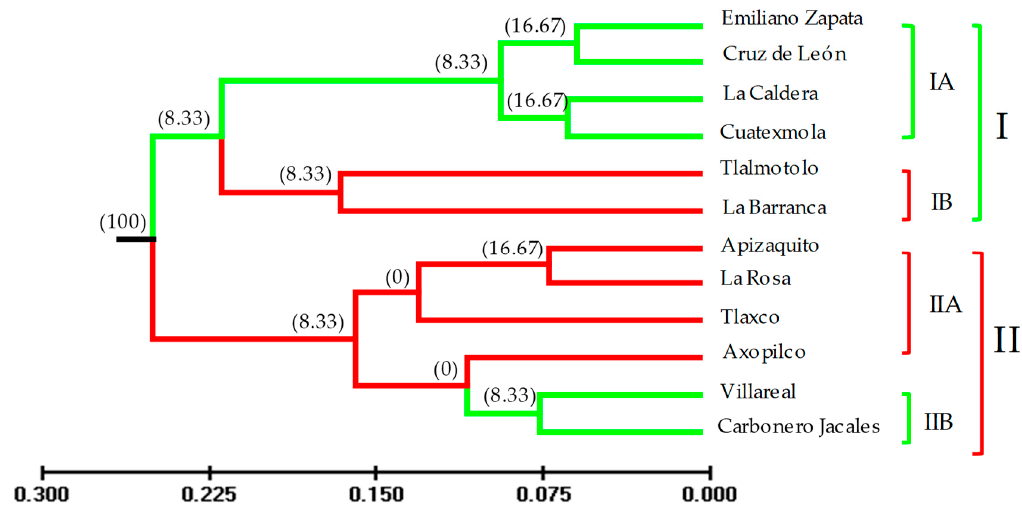
Figure 2. Graphical dispersion of 12 populations using principal coordinate analysis (PCoA), showing two main groups indicated by dotted circles with colors green (Group I) and red (Group II). Groups were formed in accordance to the UPGMA (unweighted pair group method using arithmetic average) dendrogram. The color of the dots indicate the genetic groups assigned by the STRUCTURE analysis.